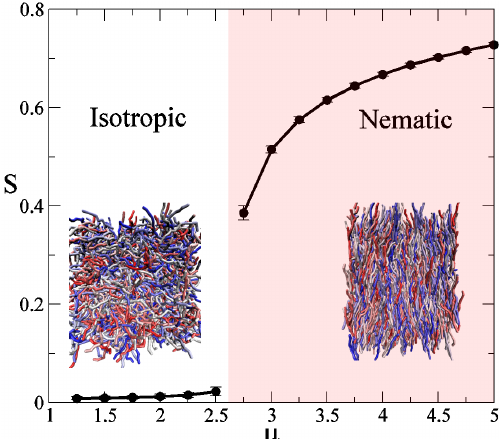
Figure 1. Global order parameter, S, as a function of the orientational coupling µ , obtained by Monte Carlo simulations (symbols). Polymer chains are composed of N = 8 segments, and κ = 3.5. Lines are only a guide to the eye. Insets are instantaneous polymer configurations in the isotropic and nematic phases, different chain colors are used to facilitate